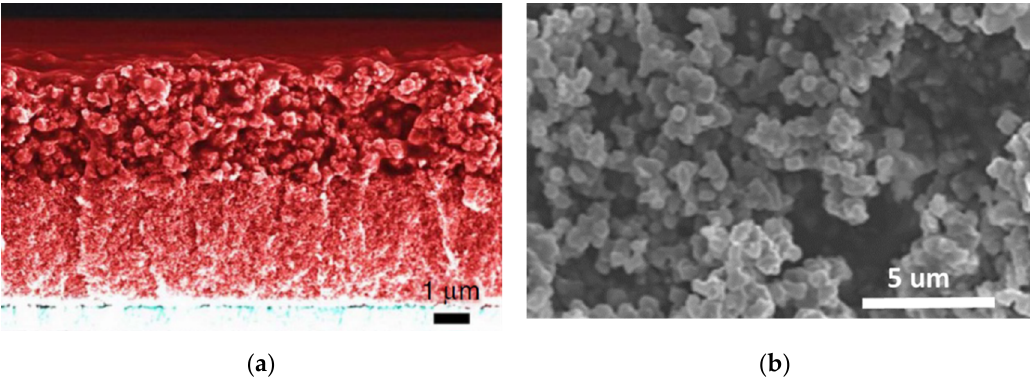
Figure 6. ( a ) The cross section SEM image of ( a ) a solid-state DSSC with PEDOT [35]. ( b ) The SEM image of porous polypyrrole [67].